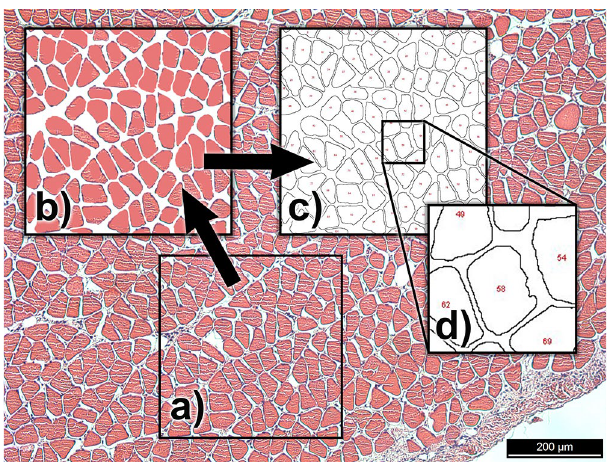
Figure 1. Stages of the histological image processing: ( a ) raw image obtained of an 8-month old rabbit soleus (Specimen ID: A54_Soleus) muscle, ( b ) 400 × 400 μm section preprocessed in Photoshop to simplify for measurement, ( c ) outline schematic produced by using the “analyze particles” function in ImageJ, ( d ) partial fibers are excluded by